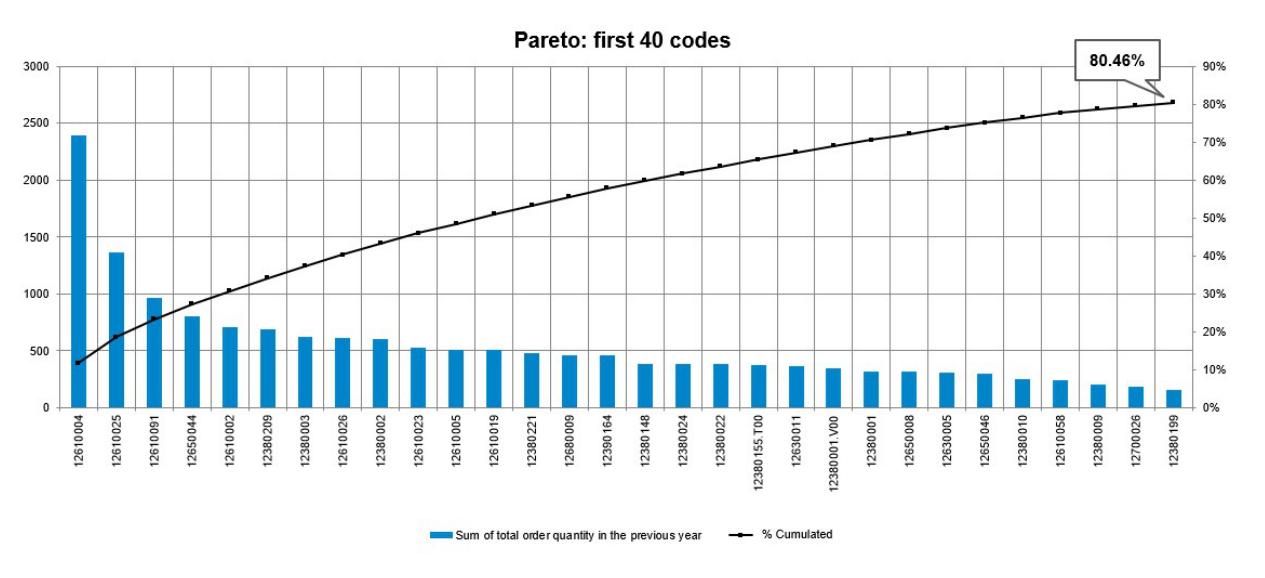
Figure 2. Pareto graph representing the 40 codes corresponding to the most ordered products in the current